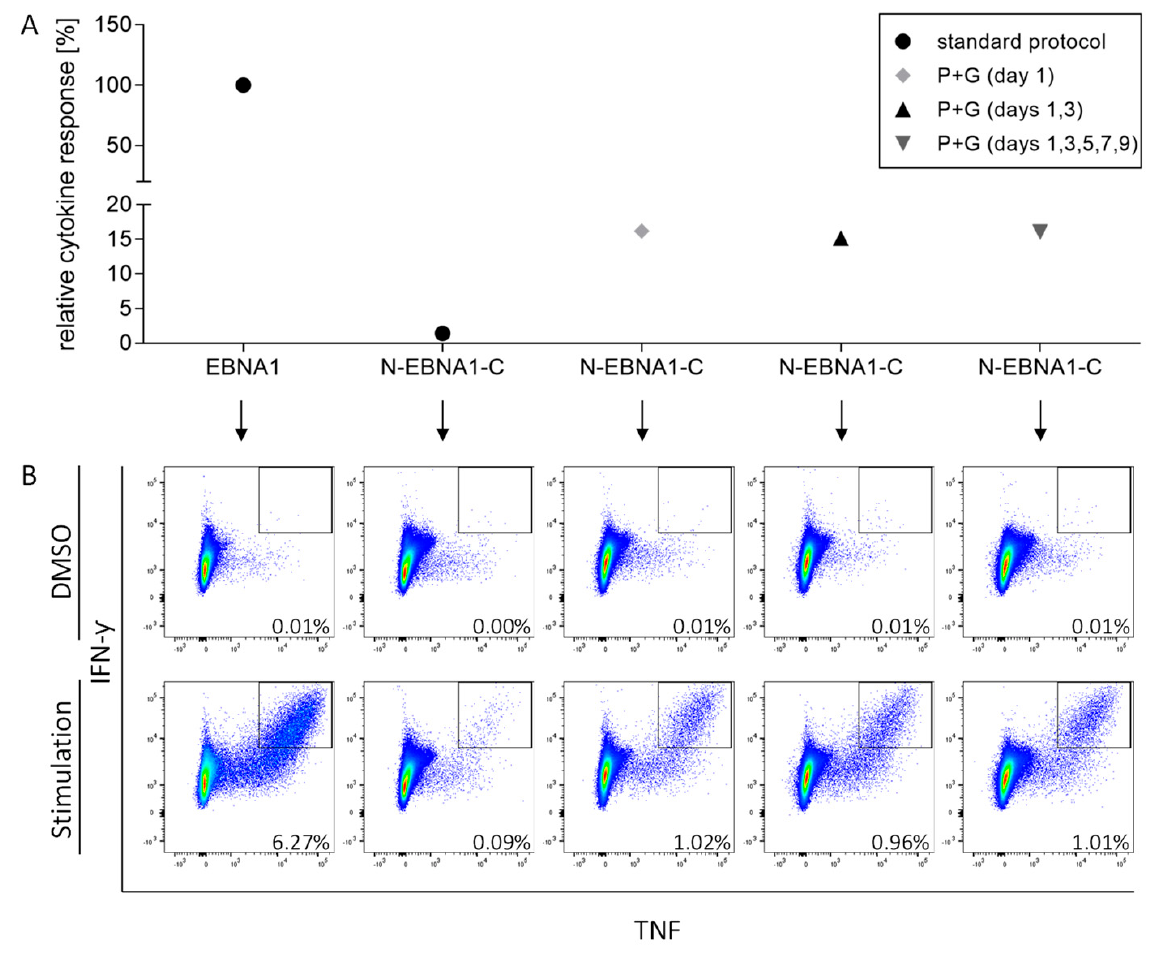
Figure 2. The addition of Poly-ICLC and GM-CSF can improve the detection of viral-specific T cells after in vitro expansion using EPs. PBMCs from healthy donor 4 (HD4) were stimulated with the short HLA class II peptide from EBV EBNA1 (EBNA1) or its N+C-terminal EP version (N-EBNA1-C), both at a concentration of 5 µ g/mL on day 1 without or with the addition of 20 µ g Poly-lCLC and 0.8 U/ µ L GM-CSF (P+G). P+G was added once or repeatedly during the 12-day culture. On day 12, cells were re-stimulated in ICS with the same peptide as on day 1 (10 µ g/mL short peptide; 50 µ g/mL EP). Single cells, live CD4 + lymphocytes, were analyzed for their cytokine production (IFN- γ + TNF + cells). ( A ) Specific cytokine response (percentage of IFN- γ + TNF + CD4 + cells after subtracting the background cytokine production in the negative control (DMSO)) after EP stimulation without (standard protocol, black dot) or with the addition of P+G on day 1 (light grey diamond), days 1 and 3 (black triangle), or days 1, 3, 5, 7, and 9 (inverted dark grey triangle) relative to the cytokine response to the matched short peptide set to 100% (standard protocol, black dot). ( B ) The respective flow cytometry dot plots are shown for each condition, either for the negative control (DMSO; upper panel), or after peptide stimulation (lower panel). Percentages indicate the frequencies of IFN- γ + TNF + events within the CD4 + cell population. Full gating strategy is depicted in Figure